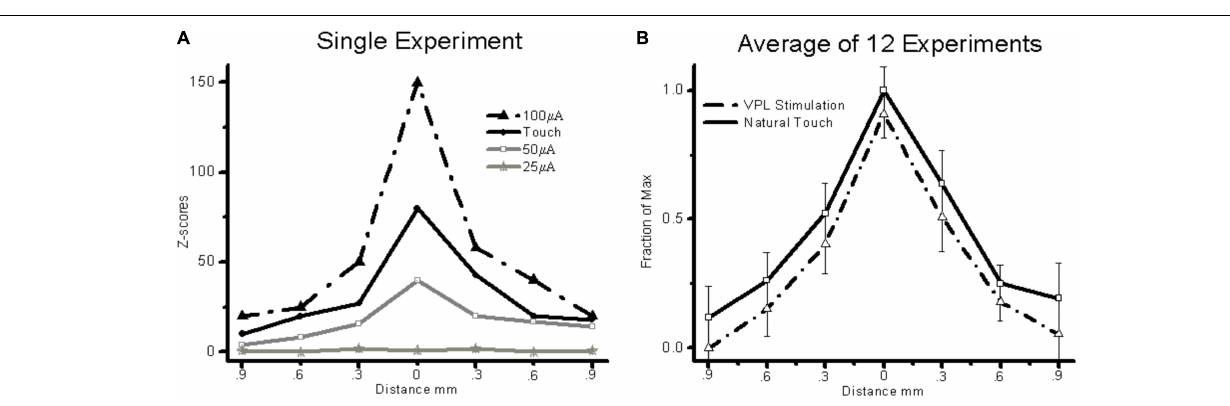
FIGURE 6 | (A) Average thalamic and S1 neural responses induced by the touch of the periphery using only channels that had a significant response for this average ( N = 1239). (B) Responses for three amplitudes of microstimulation, again only using the channels with significant responses defined as peaks of 3 STDs or more ( N = 438, 631 and 420 for 25, 50, and 100 µ A, respectively). Note that the 25 µ A peak occurs later than the other amplitudes. (C) Crosscorrelation between the average PSTHs for touch vs. the three MiSt amplitudes used most during our study. (D) Pair-wise crosscorrelation distribution between all pairs of PSTHs